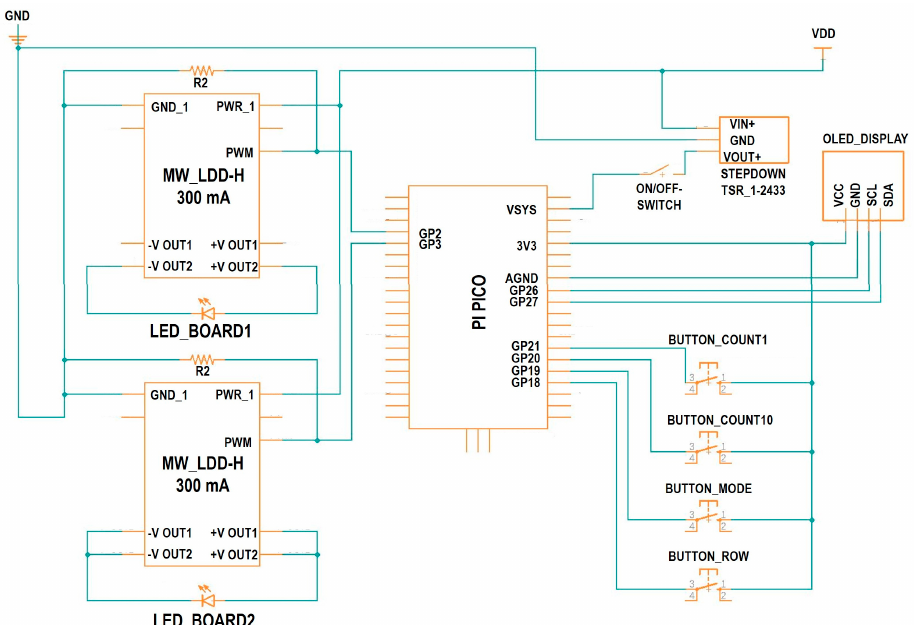
Figure A6. Electronic schematic of the controller unit. The illumination module is illustrated by the LED symbol and is controlled by the MW_LDD-H constant current source with a 300 mA forward current. The PWM input signals are grounded by the 10 k Ω resistors R1 and R2. Power for the PI_PICO (Raspberry Pi Pico) is supplied by a TSR-1 step-down converter (3.3 V). The ON/OFF switch is in the form of an interconnected pressure switch. BUTTON_XYs are tactile buttons used as input signals for the script. An OLED display is directly connected to and powered by the